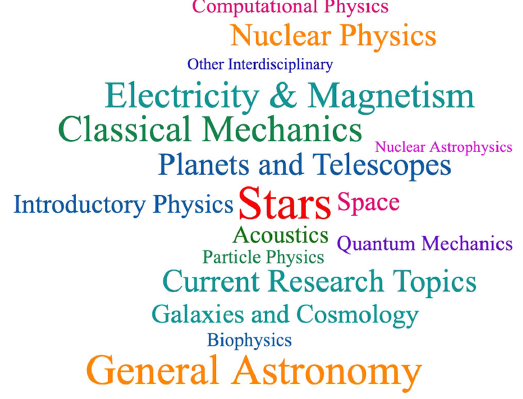
FIG. 5. Word cloud of the most covered physics and astronomy subtopics. The size of the word shows how frequently it was reported on an open-ended survey question to describe informal program